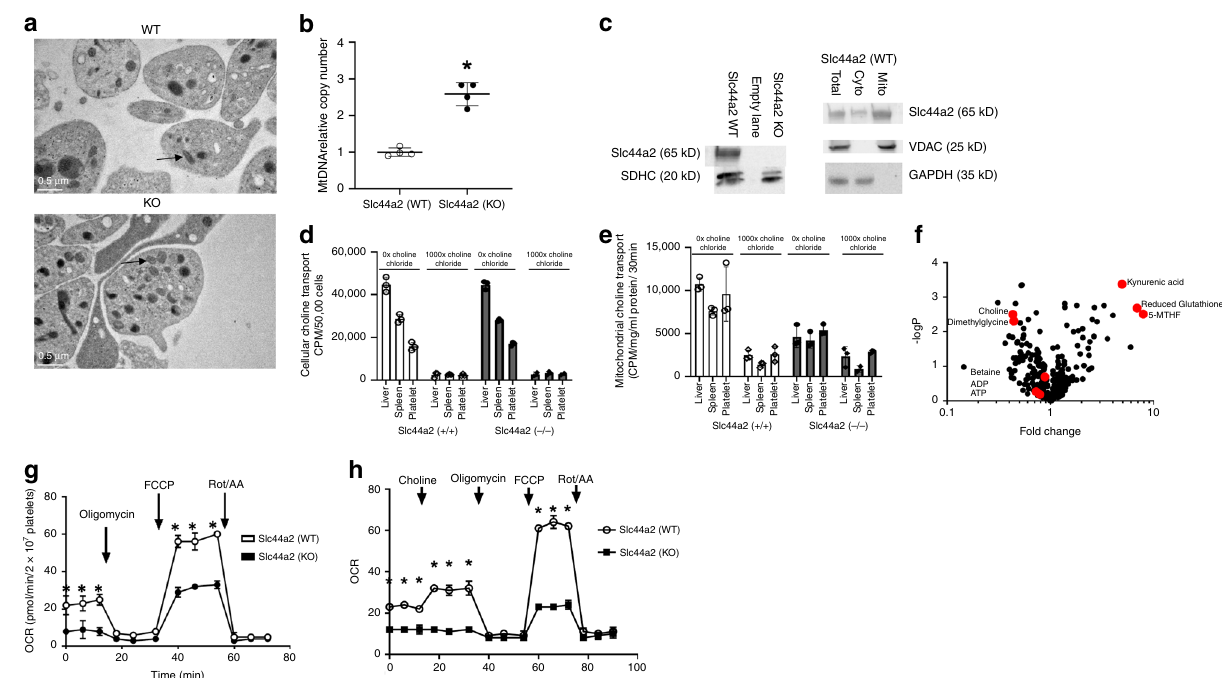
Fig. 3 Slc44a2 regulates mitochondrial number and function. a Representative transmission electron microscopy images of platelets from Slc44a2(WT) and Slc44a2(KO) mice. Arrow indicates an individual mitochondrion. b Platelet mitochondria DNA copy number measured by qPCR. n = 4. * P < 0.05 in a two-tailed Student ’ s t test ( c ) Slc44a2 is present in lysate of mitochondria puri fi ed from platelets (left immunoblot) and Slc44a2 is enriched in the mitochondrial fraction of platelets but not in the cytosolic fraction of platelets (right immunoblot). d Slc44a2 does not regulate choline transport into whole cells, as measured by cellular uptake of radiolabeled choline competed with nonlabeled choline. ( n = 3 biologically independent samples ±S.D. and * P < 0.05 for WT vs. KO). e Slc44a2 regulates transport of choline into isolated mitochondria, as measured by mitochondrial uptake of radiolabeled choline competed with nonlabeled choline. ( n = 3 biologically independent samples ±S.D. and * P < 0.05 for WT vs. KO). f Metabolite pro fi les in platelets from Slc44a2(KO) mice relative to Slc44a2(WT) mice as measured by mass spectroscopy. ( n = 2 – 3). g Mitochondrial oxygen consumption rate (OCR) of platelets from Slc44a2(KO) and Slc44a2(WT) mice: basal and uncoupled OCR are decreased in Slc44a2(KO) platelets ( n = 4 biologically independent samples ±S.D.; * P < 0.05 WT vs. KO in a two-tailed Student ’ s t test). h Mitochondrial OCR during treatment with choline ( n = 4 biologically independent samples ±S.D.; * P < 0.05 WT vs. KO in a two-tailed Student ’ s t test). For stress testing, Antimycin A = 1.0 µ M, FCCP = 1.0 µ M and Rotenone = 0.5 µ M. Choline was added at 20 µ M for all experiments. (For all panels, * P < 0.05 WT vs. KO in a two-tailed Student ’ s t test). Source data are provided as a Source Data fi